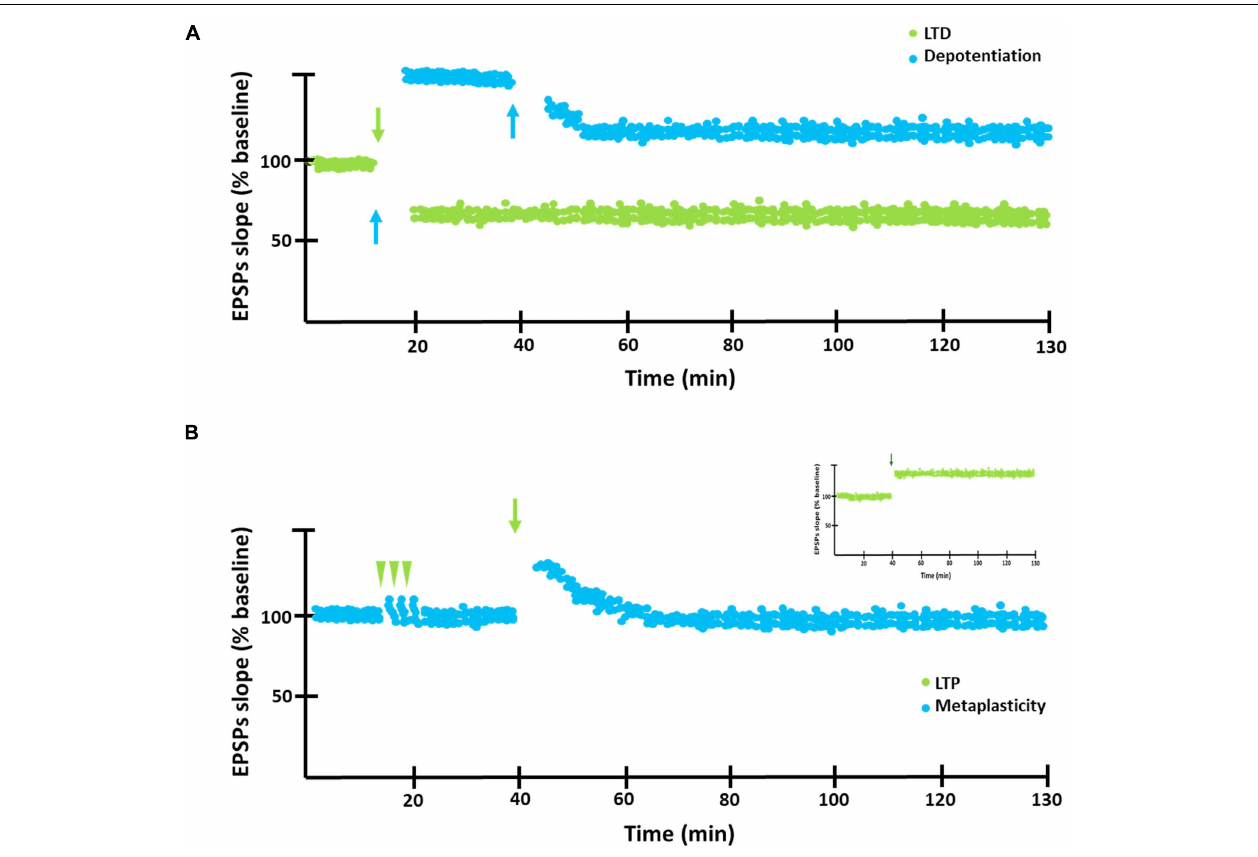
FIGURE 1 | LTD, depotentiation and metaplasticity graphic representation. (A) Graphic representation of LTD (green circles) and depotentiation (blue circles). Blue arrows indicate application of low frequency stimulation in order to induce LTD or depotentiation. (B) Metaplasticity. After receiving a weak stimulation (green arrow heads), LTP cannot be induced by applying a high frequency stimulation (green arrows) capable of inducing this phenomenon in a control preparation as observed in the inset. That is, the previous stimulation modifies the threshold to induce